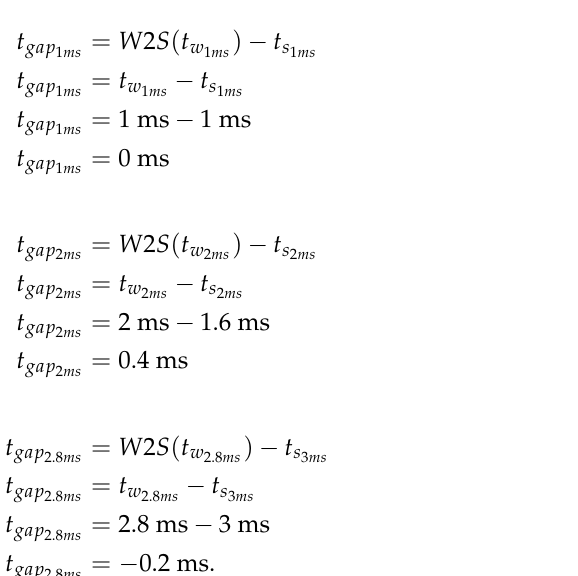
Figure 2. Visualisation of t gap between the t s 1 = 1.6 ms and W 2 S ( t w 1 ) = 2 ms. The t gap calculation allows determining how far the simulation diverges from a given wall-clock time using the simplified calculation of W 2 S ( t w ) from Equation (7). Equations (8) and (9) show the calculation of t gap at t w = 1 ms, t w = 2 ms and t w = 2.8 ms, respectively. Values for t s at those time points can be obtained from Figure